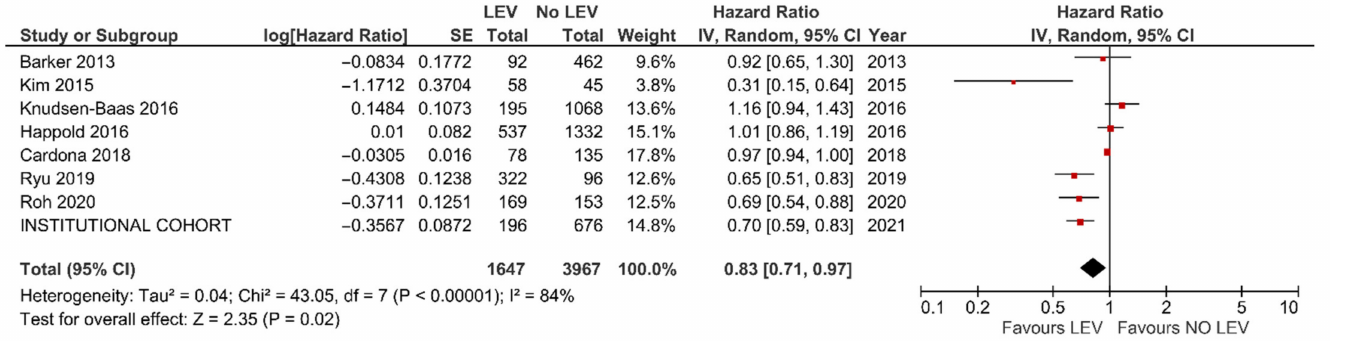
Figure 3. Meta-analysis of studies reporting on OS of GBM patients with and without LEV treatment.